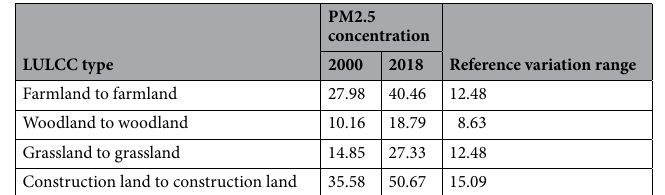
Table 4. Dynamic PM 2.5 concentrations in the non-LULCC areas (units: μg/m 3 ).